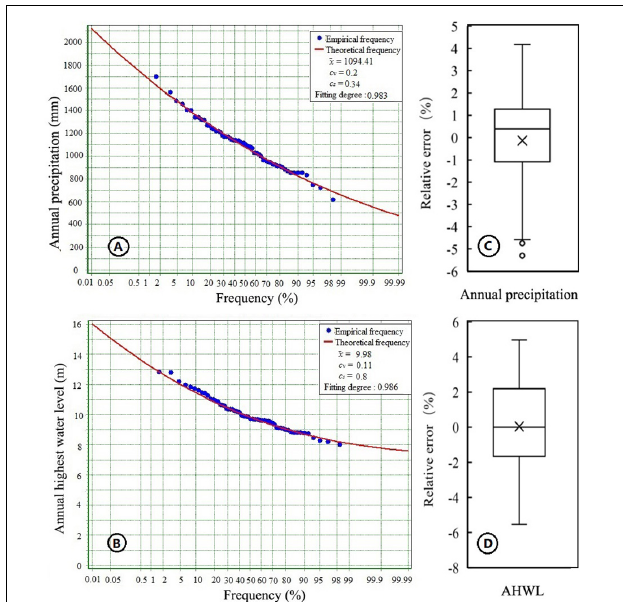
FIGURE 3 | Probability of univariate empirical scatter plots and fitted theoretical probability curve ( A : Annual precipitation; B : Annual maximum water level) and the relative error between empirical frequency and theoretical frequency ( C : Annual precipitation; D : Annual maximum water